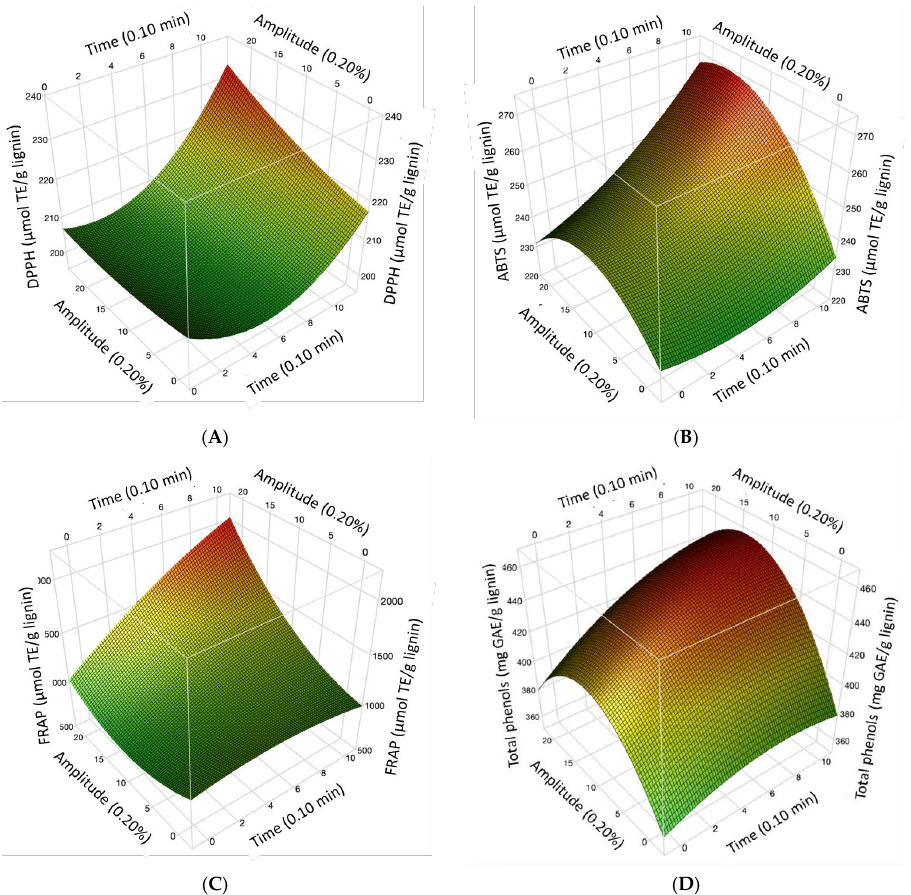
Figure 1. Response surface: Effect of ultrasonic pulses on the antioxidant capacity by ( A ) DPPH, ( B ) ABTS, ( C ) FRAP, and ( D ) Total phenols in sorghum lignin. Table 3. Matrix of the central design composed of the different treatments with and without high- power ultrasonic pulses in sorghum